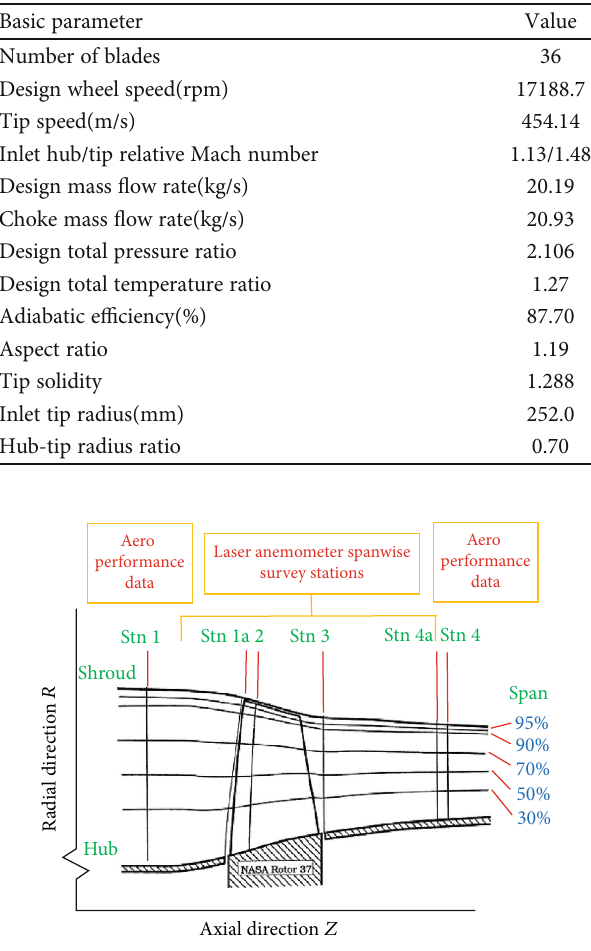
Table 2: Basic parameters of Rotor 37.